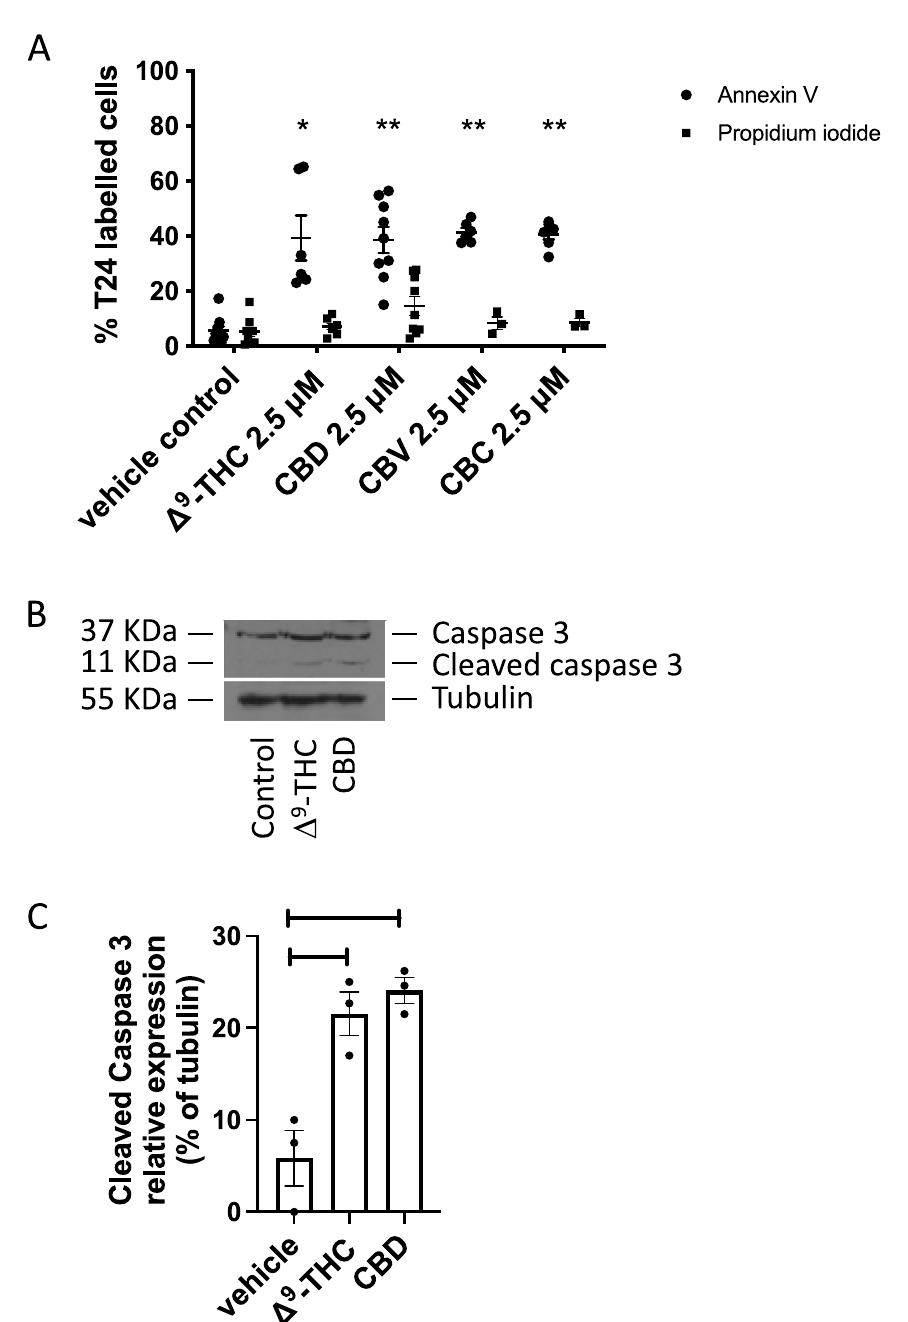
Fig. 3 Effects of cannabinoids on apoptosis. T24 cells were treated for 24 h with either the methanol vehicle, Δ 9 -tetrahydrocannabinol, cannabidiol, cannabivarin, or cannabichromene. A Histogram showing the % of annexin V-labelled cells and % cells stained for propidium iodide. Cells were counted from three random fields of view on a fluorescence microscope. * p < 0.05, ** p < 0.01, n 3. B Western blotting analysis was performed = using an anti-caspase-3 antibody, and β -tubulin was included as a loading control, where a representative blot of n 3 experiments is shown. = Cleaved caspase 3 is indicative of activation of this cascade. C Quantification of the cleaved caspase 3 relative to tubulin from Western blotting analyses. Results represent the means SEM of 3 ±